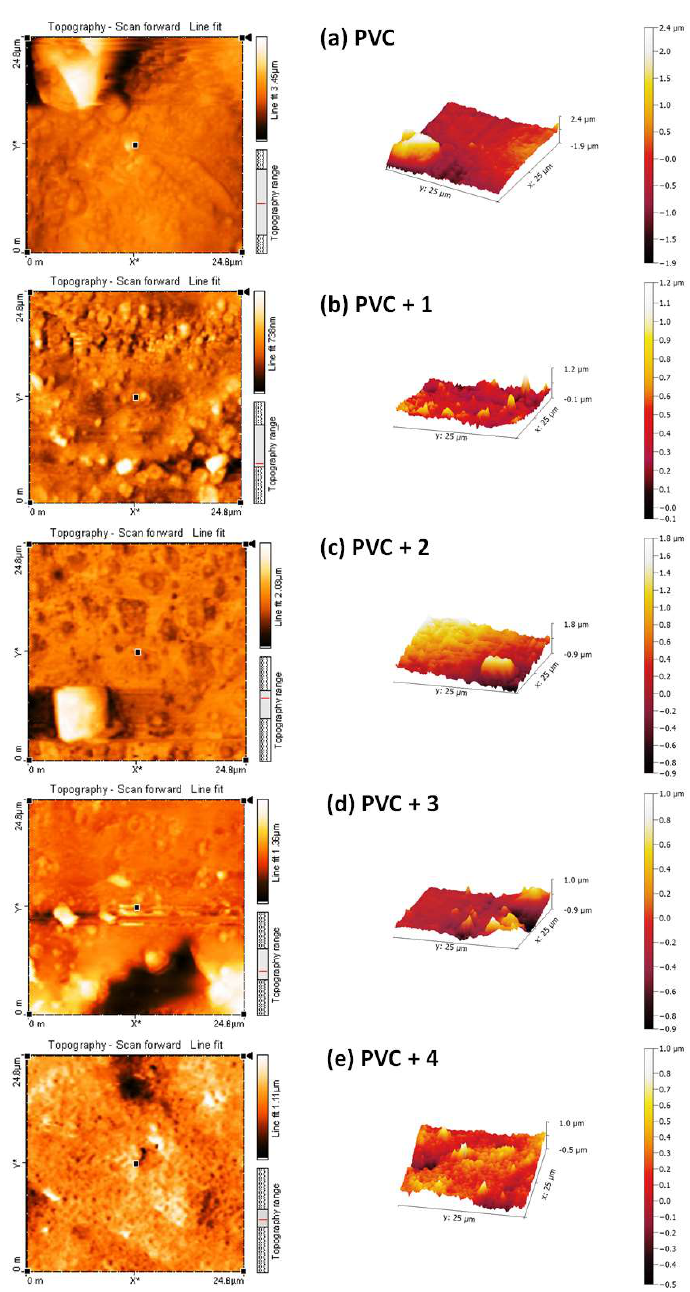
Figure 13. 2D and 3D atomic force microscopy (AFM) images of the ( a ) blank PVC film and ( b – e ) PVC films containing tin(IV) compounds 1 – 4 after irradiation (300 h).